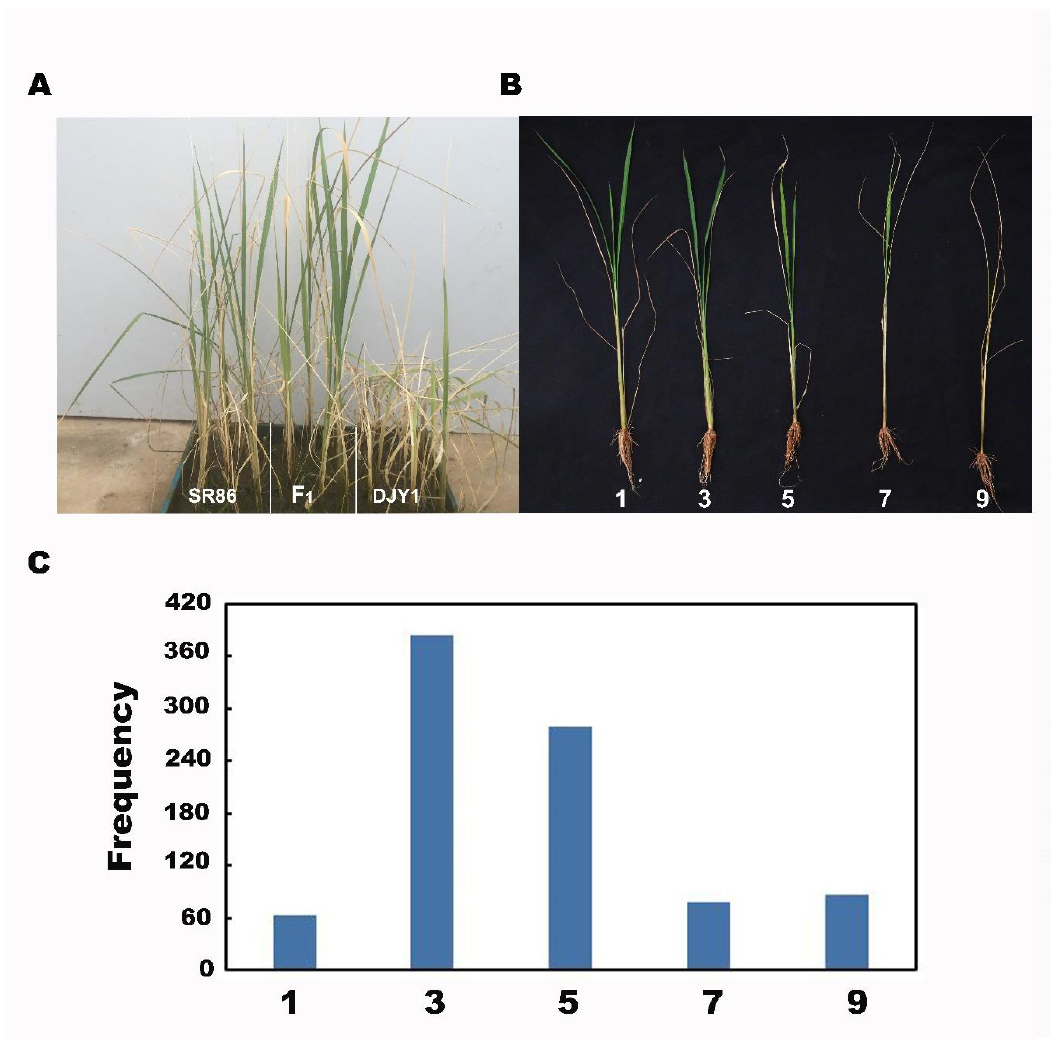
Figure 1. The phenotype and genetic analysis of SR86 under salt stress. ( A ) The phenotype of SR86, DJY1, and F 1 after being treated with 1.2% NaCl solution for 8 d. ( B ) The phenotype classification